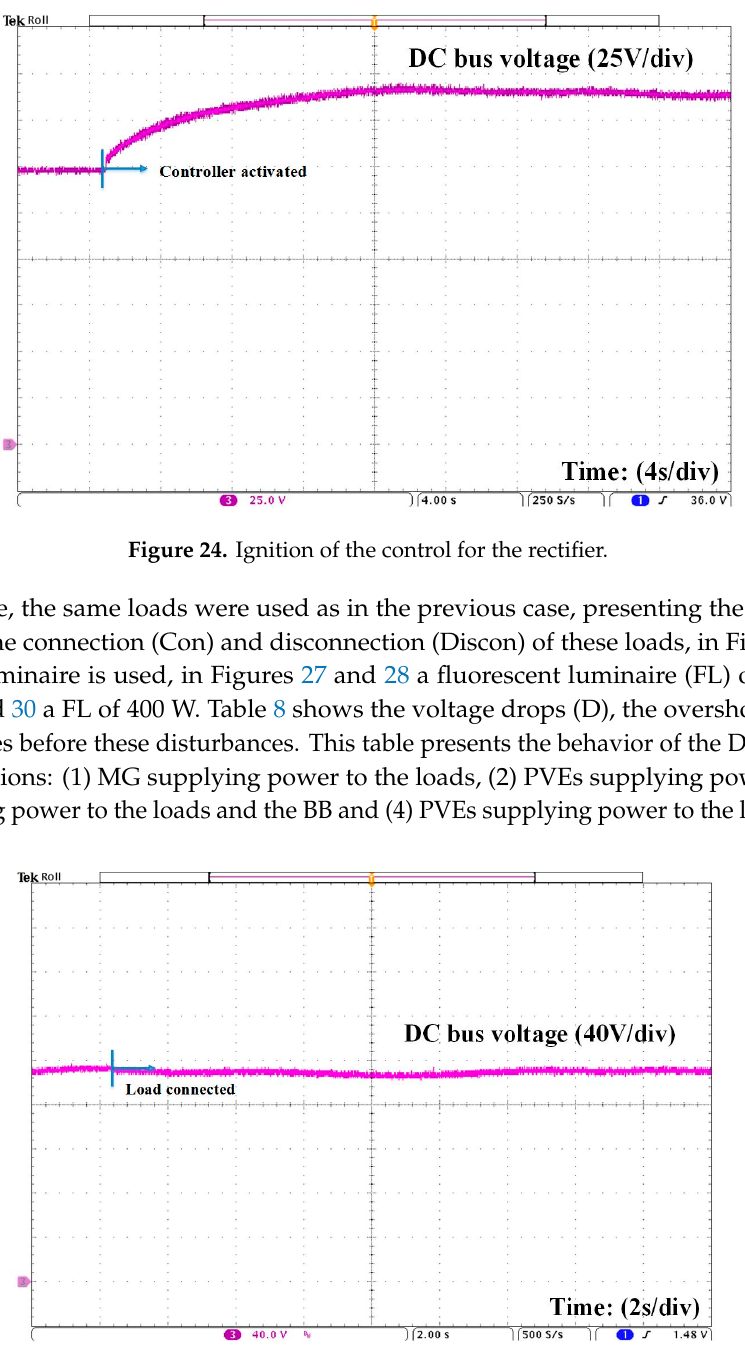
Figure 25. Connection of 115 W LED lamp.